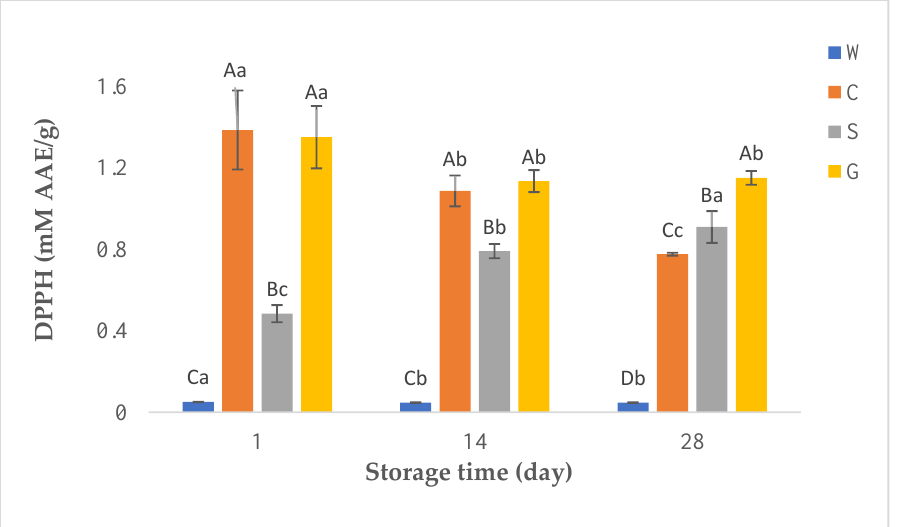
7 of 18 Figure 2. TPC (g.GAE/g) in probiotic fermented whey beverages enriched with kiwi powder. a,b Means ± standard deviations in the same beverage group with different superscript lowercase let- ters are significantly different ( p < 0.05); A – C Means ± standard deviations in the same storage day with different superscript uppercase letters are significantly different ( p < 0.05). C = probiotic fer- mented beverage produced from cow WPC and enriched with kiwi powder, G = probiotic fer- mented beverage produced from goat WPC and enriched with kiwi powder, S = probiotic fermented beverage produced from sheep WPC and enriched with kiwi powder, W = probiotic fermented bev- erage produced without WPC and enriched with kiwi powder. 3.3.2. 2,2-Diphenyl-1-Picrylhydrazyl Radical-Scavenging Capacity (DPPH) DPPH, a stable nitrogen-based free radical, has a violet color. However, it is reduced to a yellow-colored diphenylpicrylhydrazine radical, which can be measured colorimetri- cally, by accepting an electron from the antioxidant compound. Thus, antioxidants that are able to carry out this reaction are considered radical scavengers [41]. Figure 3 shows